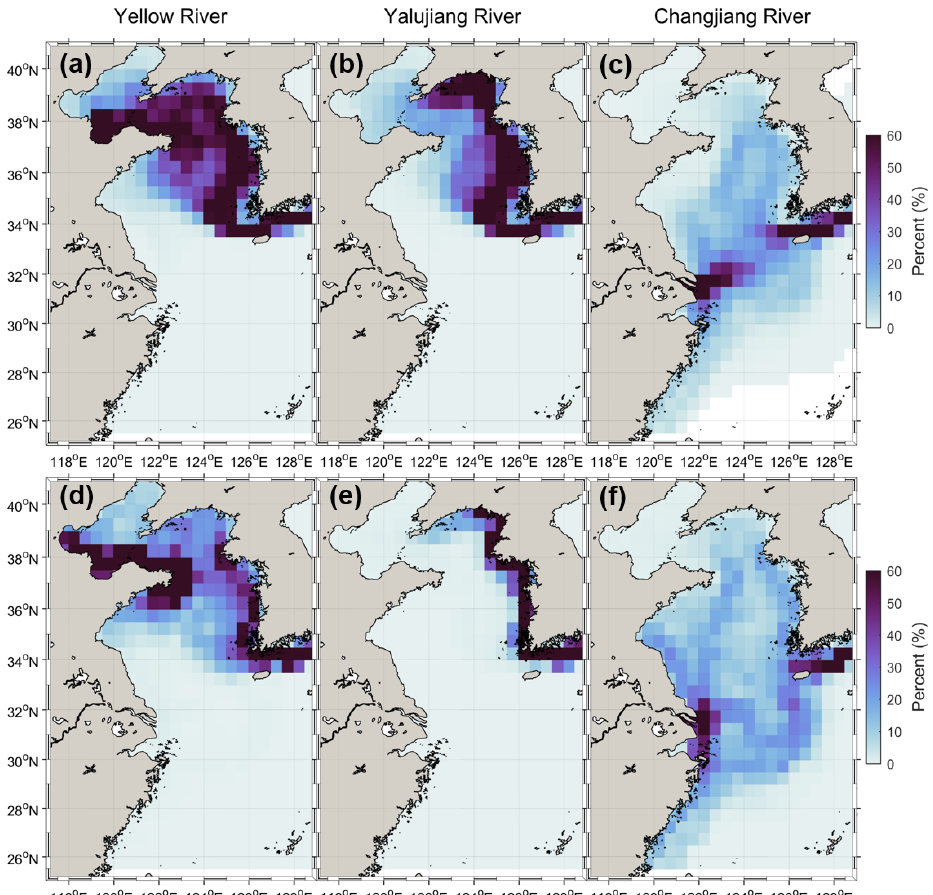
Figure 2. The annually averaged emergence probability of the particles released at the three rivers’ boundaries for the control run (a–c) and no-tide case (d–f) , which are indicated by the emergence probability of the particles in the grids (in